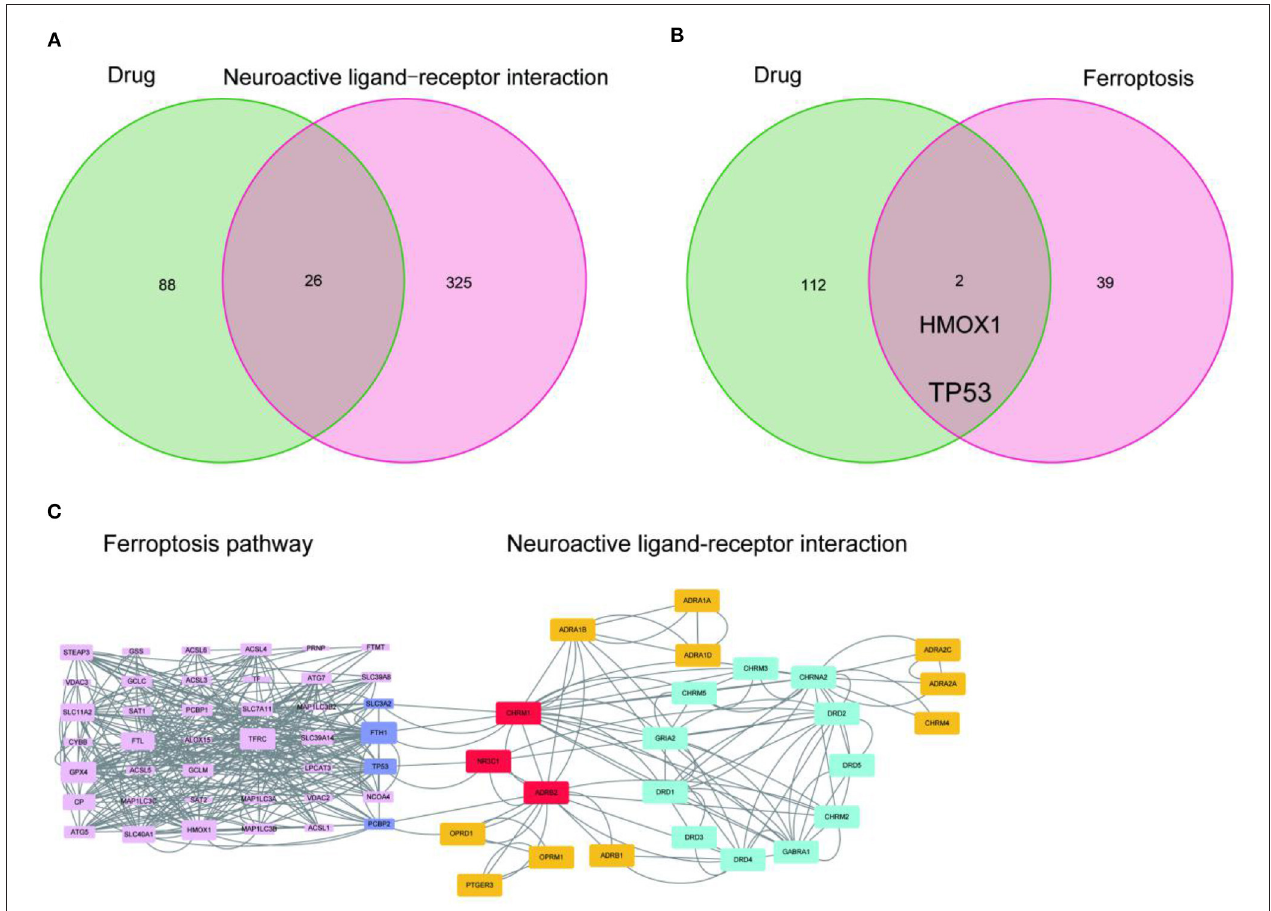
FIGURE 2 | Network analysis of the active compounds of EUO-TT L. mediating the neuroactive ligand-receptor interaction pathway regulating ferroptosis. Intersection analysis of drug-neuroactive ligand-receptor interaction pathway (A) ; Intersection analysis of drug-ferroptosis pathway (B) ; PPI network of neuroactive ligand-receptor interaction pathway - ferroptosis pathway (C)